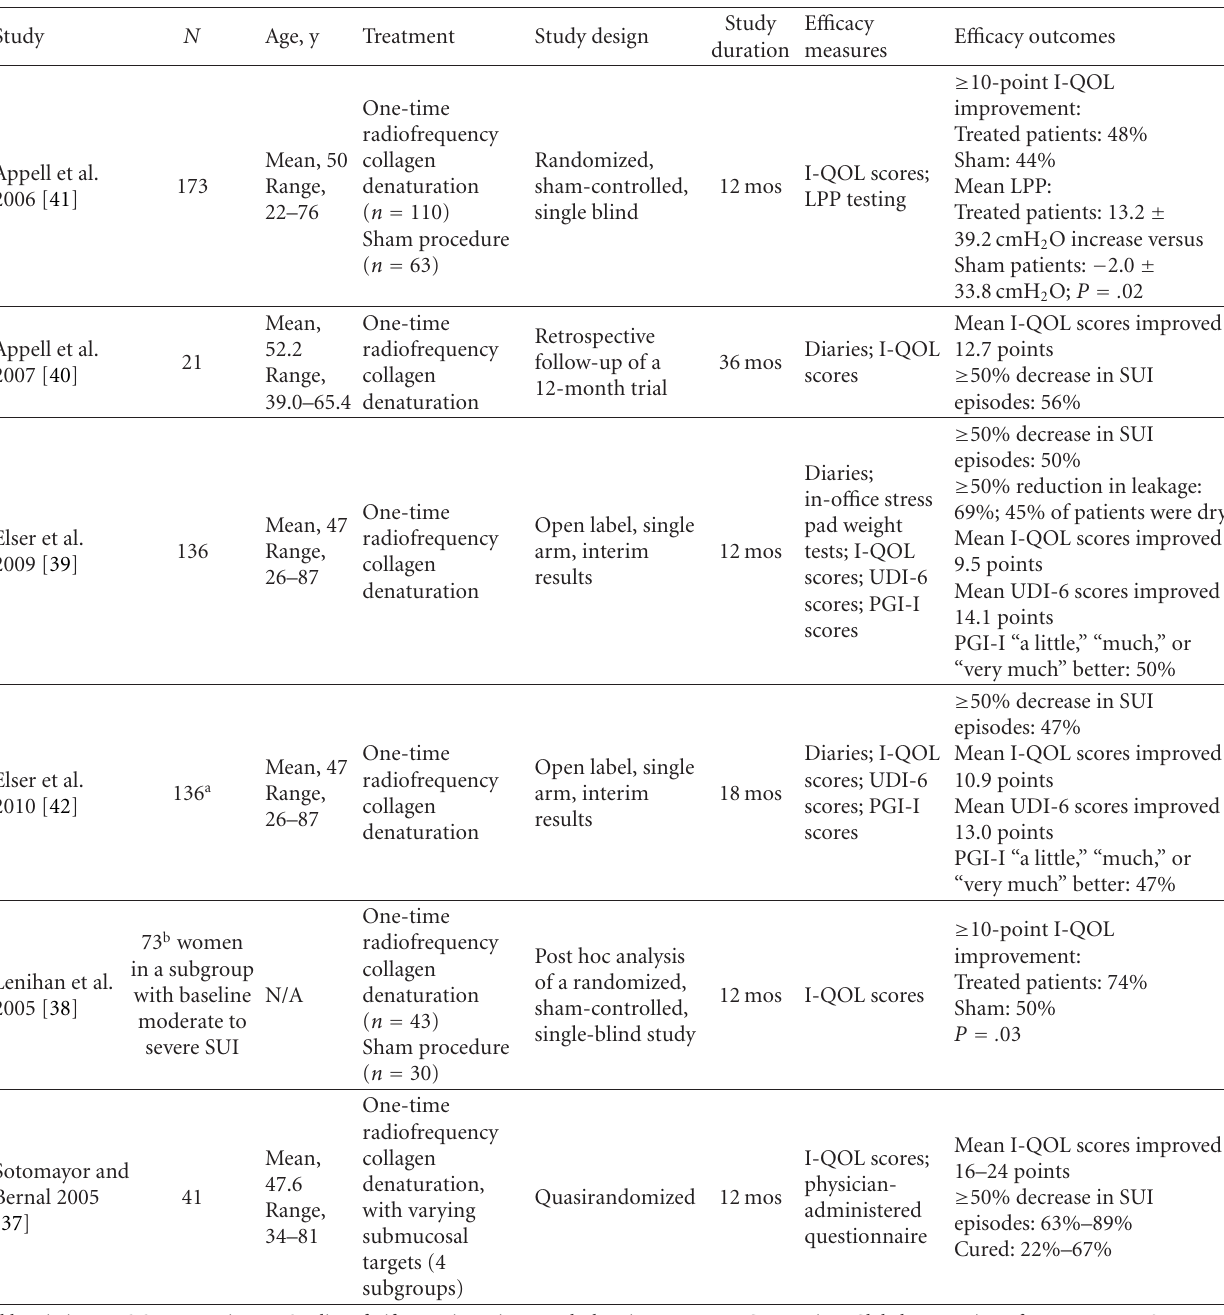
Table 3: Summary of transurethral radiofrequency collagen denaturation